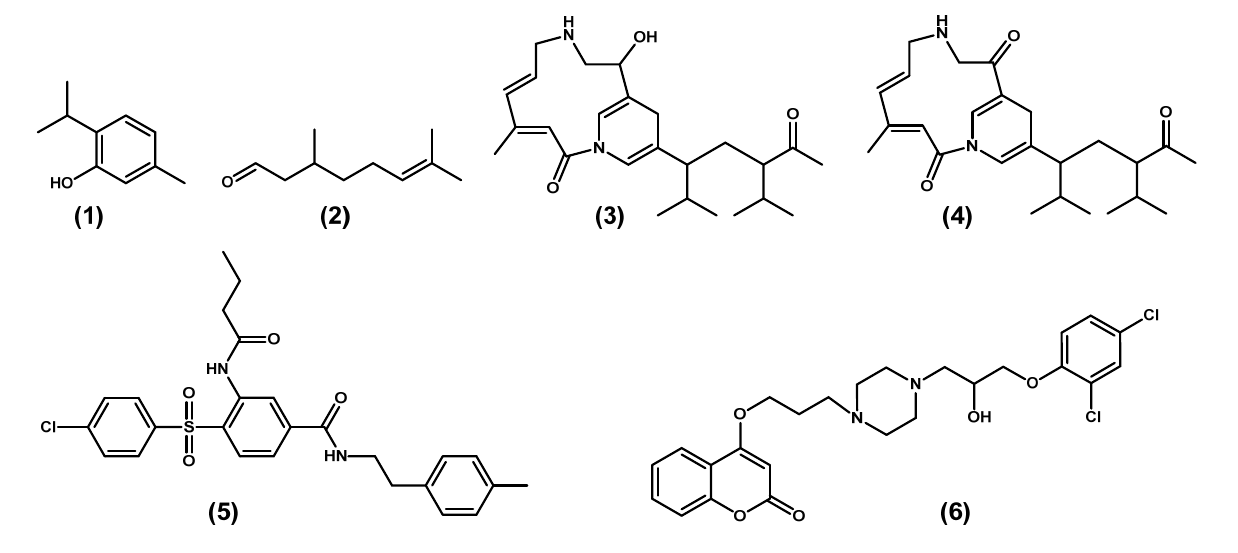
Figure 5. Chemical structure of reported RpfF inhibitors: ( 1 ) thymol, ( 2 ) citronellal, ( 3 ) chumacin ‐ 1, ( 4 ) chumacin ‐ 2, ( 5 ) rifampicin analogues, ( 6 ) and coumarin derivative. Table 1. Overview of reported RpfF inhibitors.